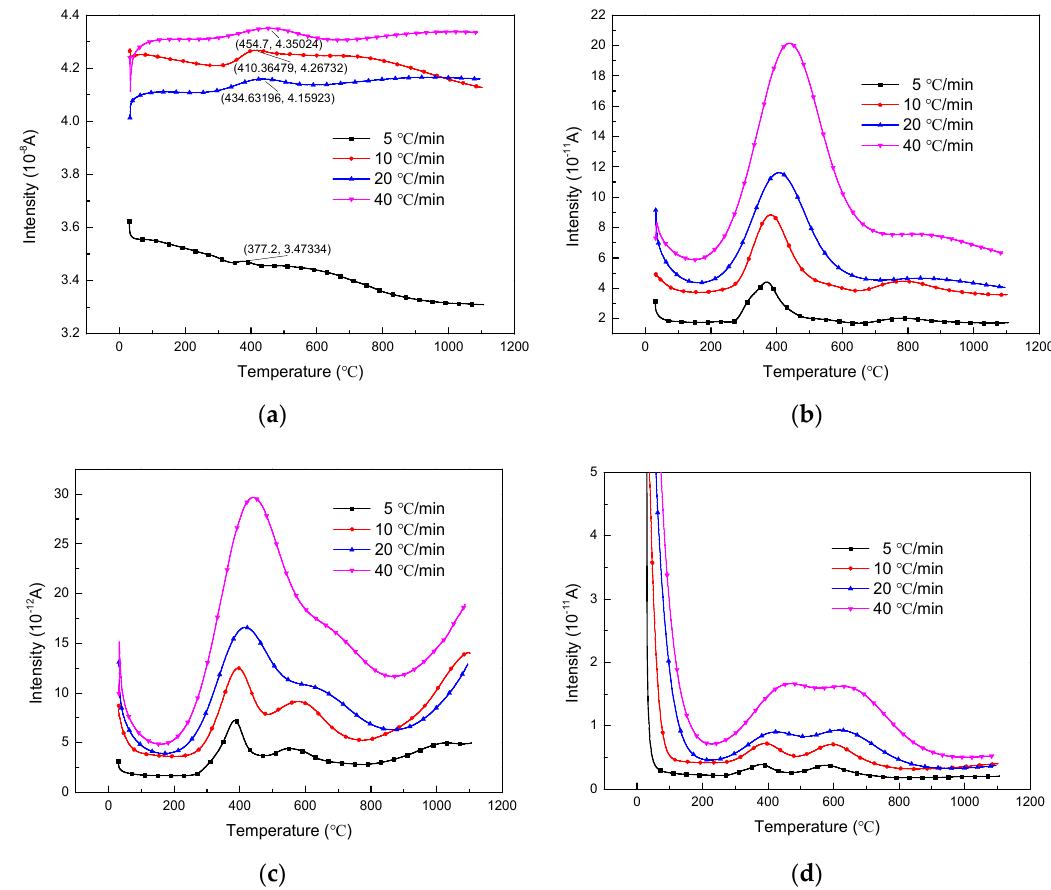
Figure 12. ( a ) CO, ( b ) H 2 O, ( c ) CO 2 and ( d ) CH 4 release against temperature with the heating rate during pyrolysis.